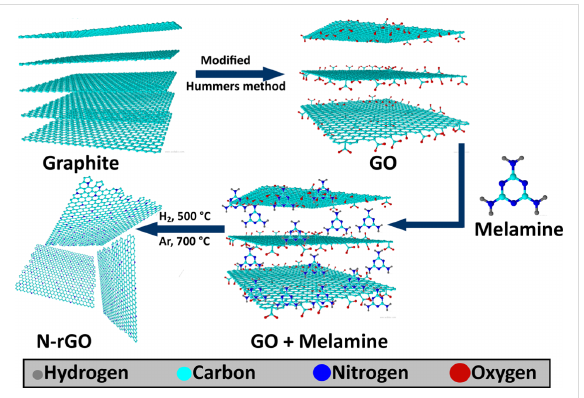
Figure 1: Schematic illustration for the synthesis of